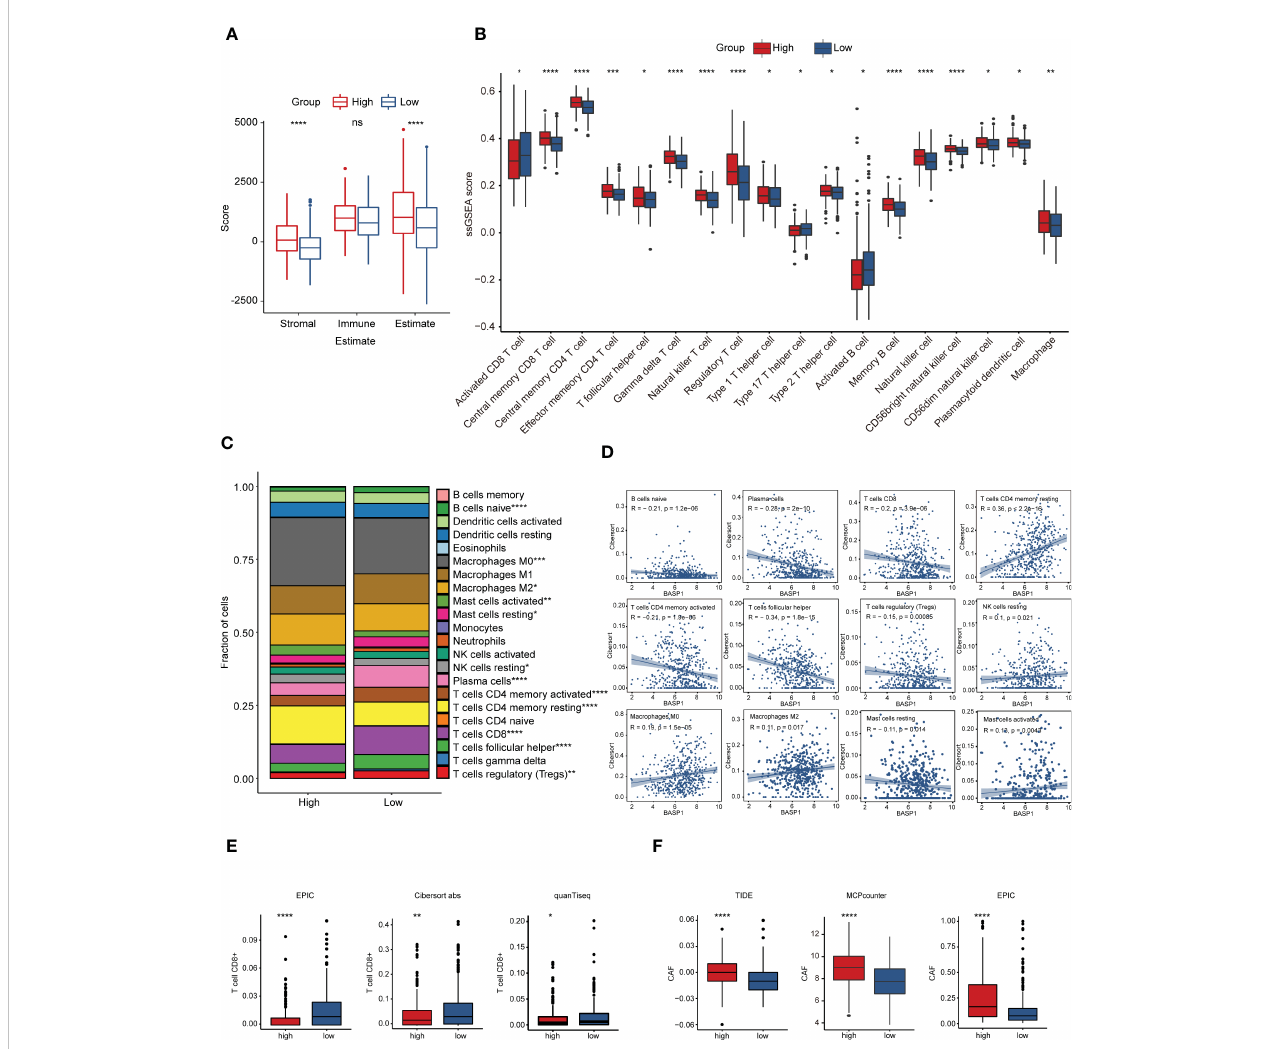
FIGURE 5 Immune characteristics in different subtypes based on BASP1 expression in HNSCC. (A) The immune score and stromal score in BASP1 high group and BASP1 low group determined using ESTIMATE. (B) Boxplot of immune cells in fi ltration with ssGSEA score in BASP1 high group and BASP1 low group. (C) The fractions of immune cells in BASP1 high group and BASP1 low group. (D) The correlations between BASP1 expressions and cell proportions. (E) Boxplot of the CD8 + T cells in fi ltration evaluated by EPIC, CIBERSORT-ABS and quanTiseq. (F) The stromal cell fractions in TME with TIDE, MCPcounter and EPIC. * p < 0.05; ** p < 0.01; *** p < 0.001; **** p <